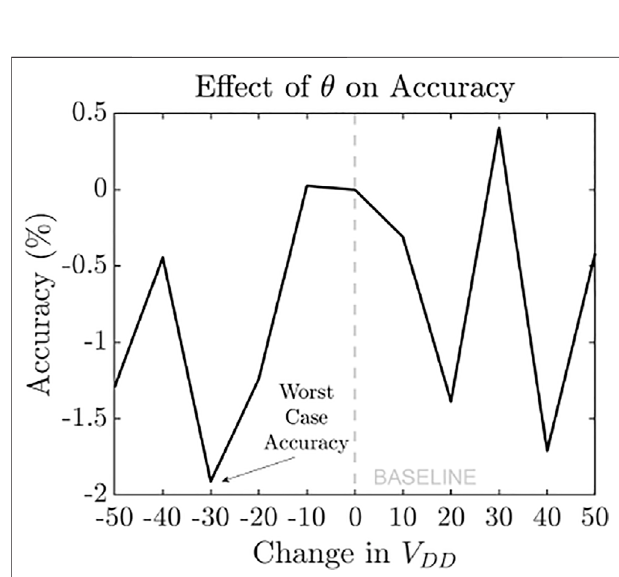
FIGURE 6 | Implemented 3-layer SNN (Diehl et al., 2015).